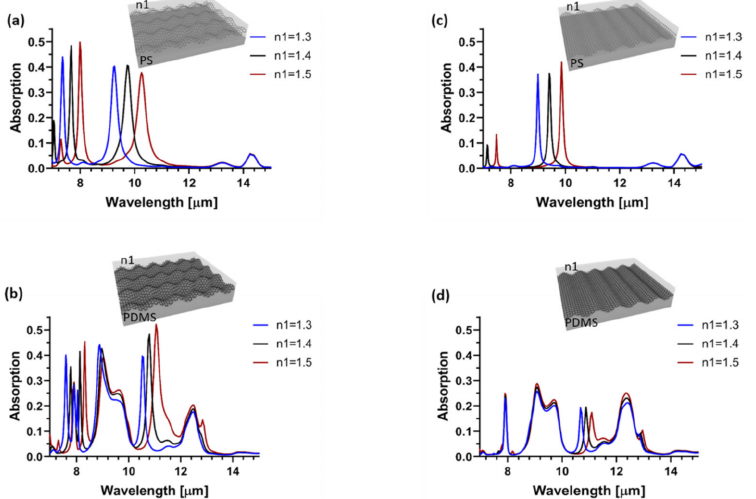
Figure 3. Plasmonic resonance shifts of biaxially crumpled graphene supported on ( a ) flat PS and ( b ) corrugated PDMS substrate; and those of uniaxially crumpled graphene on ( c ) flat PS and ( d ) corrugated PDMS substrate, when the RI of sample n 1 changed from 1.3 to 1.5, with geometrical parameters of W = 250 nm; H = 300 nm; E f = 0.64 eV; and µ = 10,000 cm 2 /(V ·